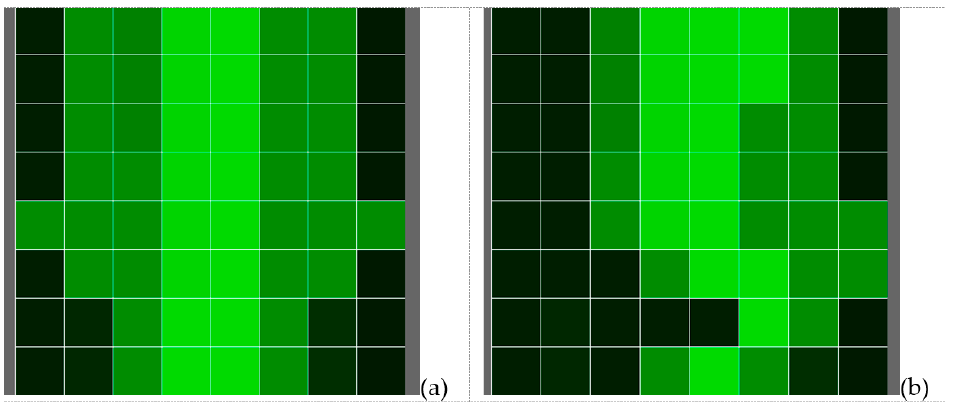
Figure 13. Results from the measurements: ( a ) back posture; ( b ) sideways posture.